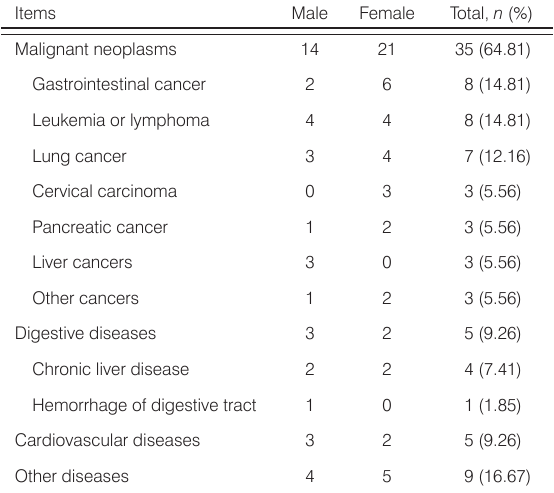
Table 2. Disease categories of suicidal inpatients.